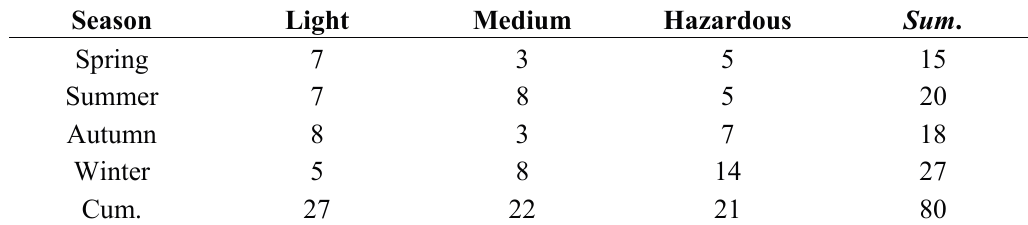
Table 2. Number of PPEs with average PM 2.5 concentration of different levels in each season. Season Light Medium Hazardous Sum